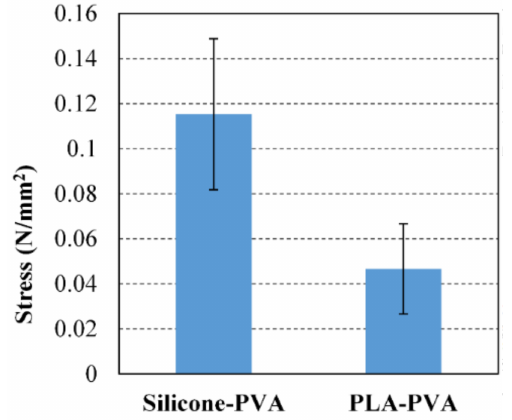
Figure 5. Adhesion strength at the interfaces of poly-vinyl alcohol (PVA) over silicone and poly-lactic acid (PLA) over PVA.